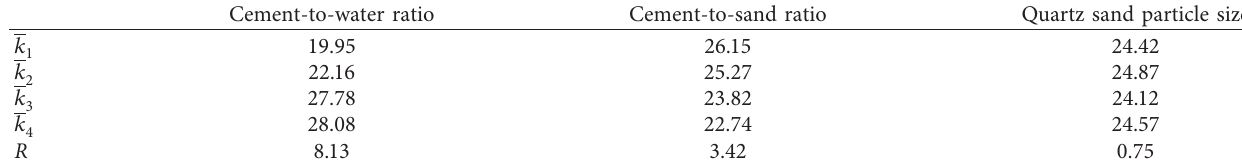
Table 4: Range analysis of compressive strength.